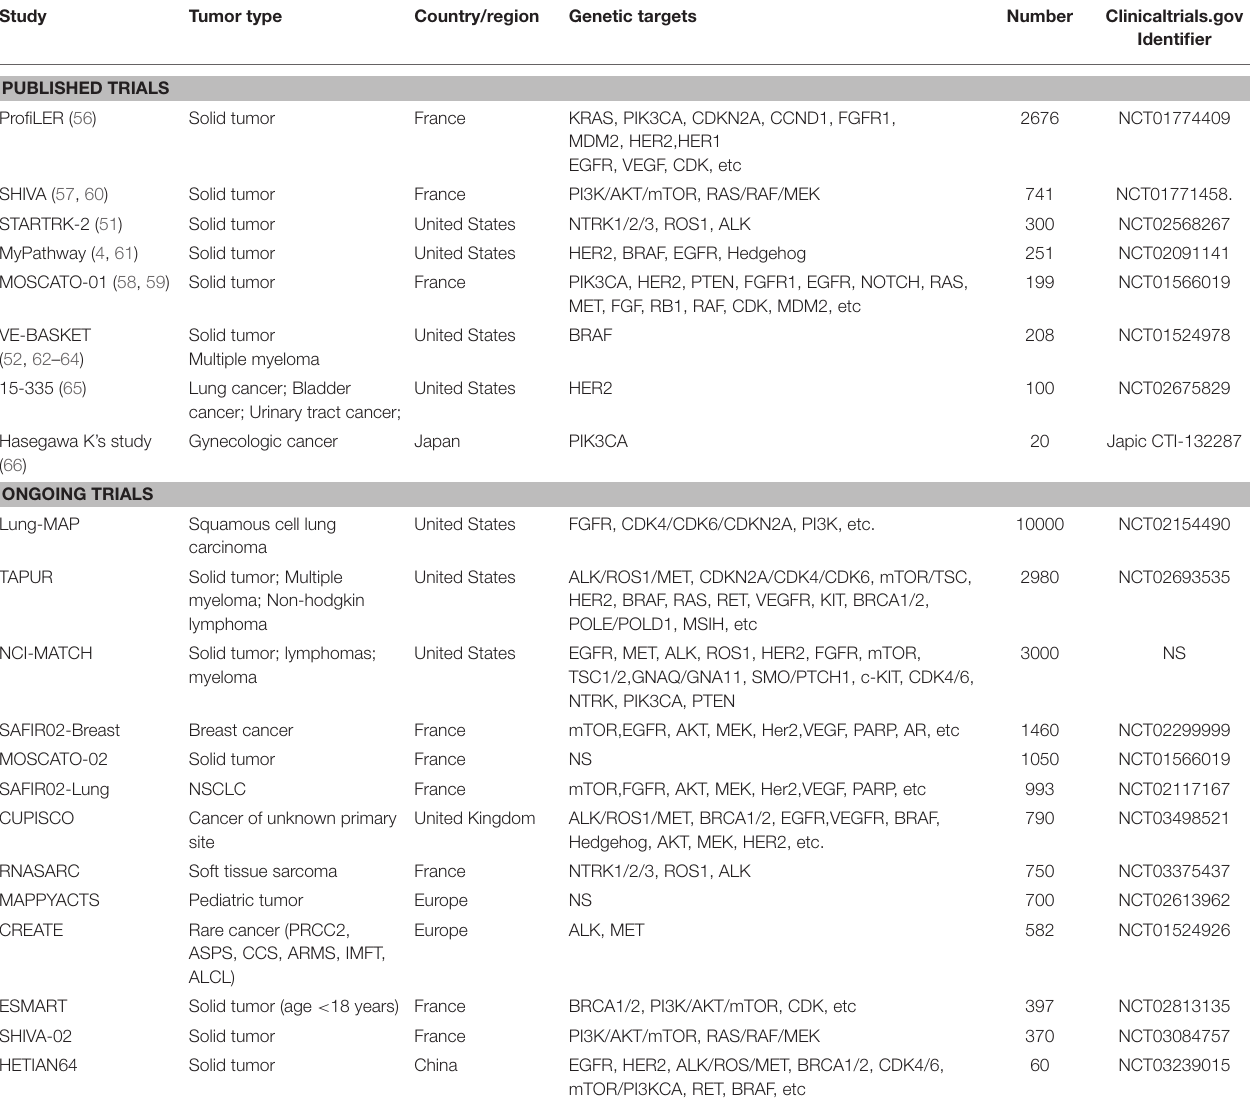
TABLE 2 | Published and ongoing basket trials for intractable